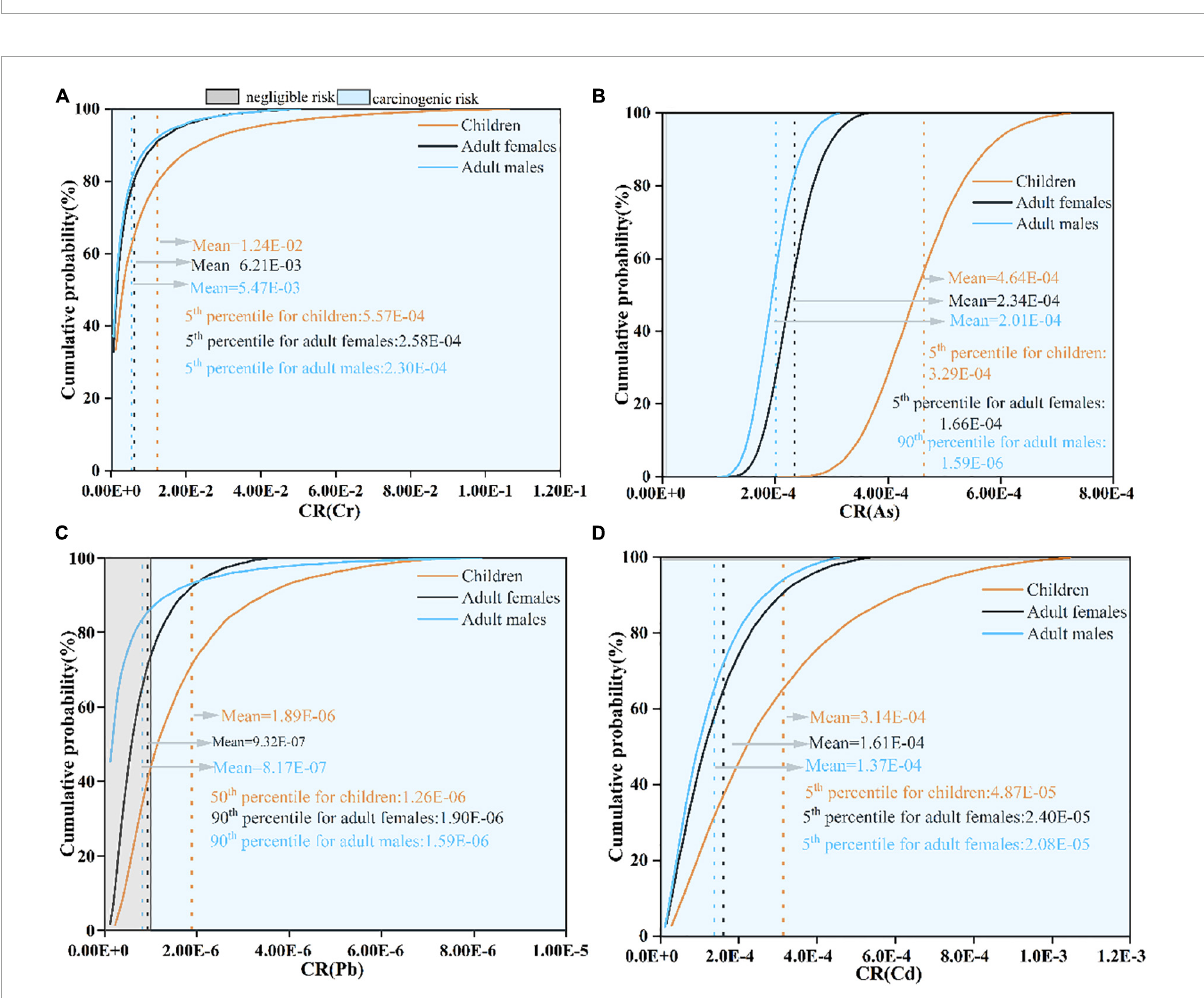
FIGURE6 Cumulative probabilistic distributions of carcinogenic risk (CR) of PTE through wheat grain ingestion for three populations. [ (A) Cr; (B) As; (C) Pb; (D) Cd].